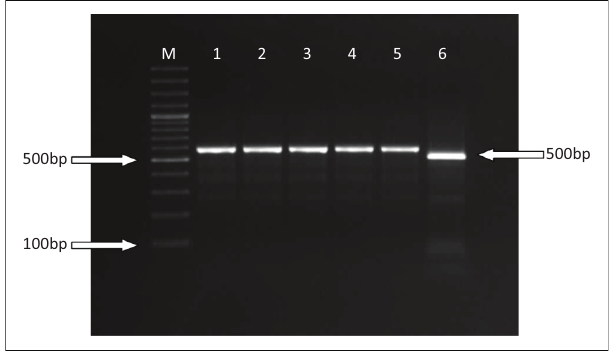
FIGURE 2: Restriction fragment length polymorphism analyses of the partial VP2 gene polymerase chain reaction amplicon (583 base pairs) of canine parvovirus- 2a/2b/2c variants. Line M: 100 base pairs Deoxyribonucleic acid ladder (Thermoscientific, United States); Line 1: undigested canine parvovirus- 2a; Line 2: undigested canine parvovirus-2b; Line 3: undigested canine parvovirus-2c; Line 4; canine parvovirus-2a undigested with Mbo II; Line 5: canine parvovirus- 2b undigested with Mbo II; Line 6: canine parvovirus-2c digested with Mbo II .